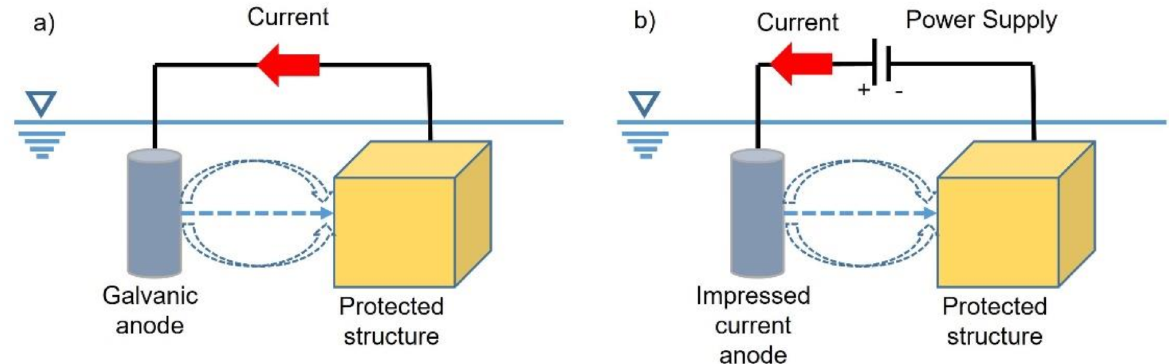
Figure 1. Cathodic protection on ships: ( a ) by galvanic anodes and ( b ) by impressed currents. In both cases, the ship hull acts as the zone for the cathodic oxygen reaction and its potential is moved to a lower value. In the galvanic anode configuration, the necessary cur- rent spontaneously flows, as in a battery. The anode is permanent in the impressed current configuration and hosts the anodic reaction, chloride’s oxidation in seawater. This system does not run spontaneously, and the power supply provides the necessary external